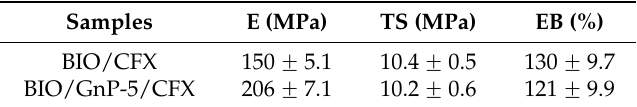
Table 3. Elastic modulus (E), tensile strength (TS), and elongation at break (EB) of BIO/CFX and BIO/GnP-5/CFX.